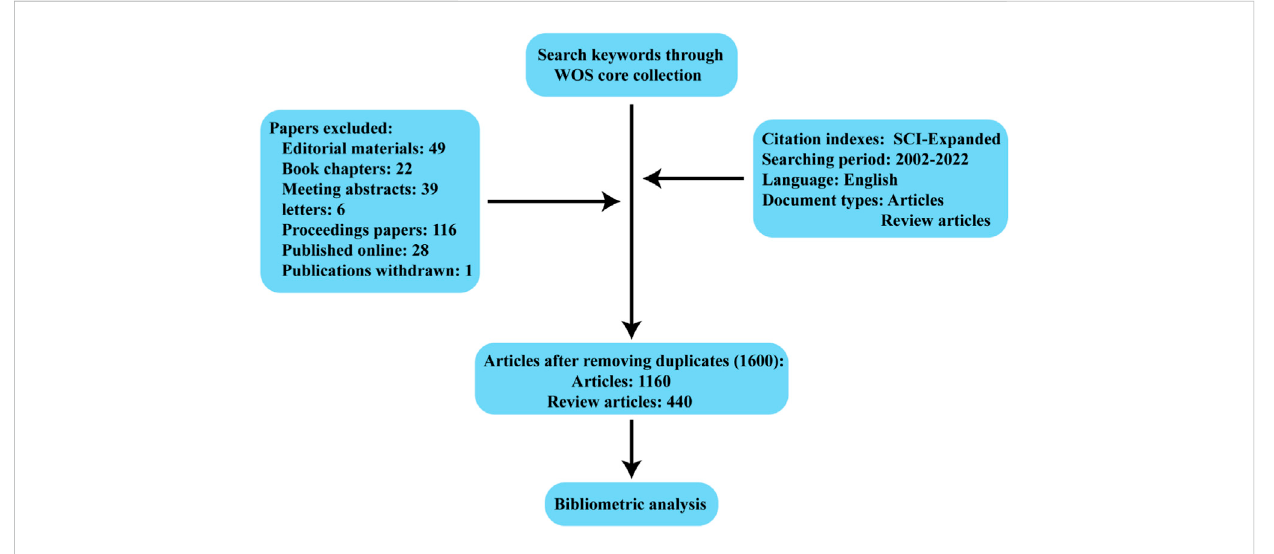
FIGURE 1 Schematic diagram of the search